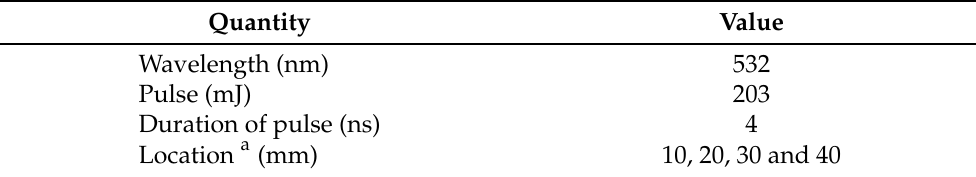
Table 18. Laser Parameters.